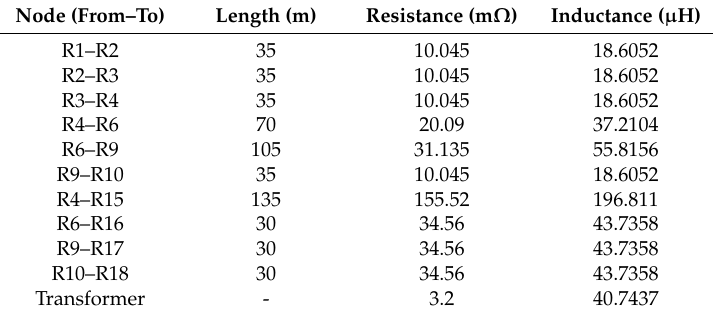
Table 1. Line parameters of the benchmark.